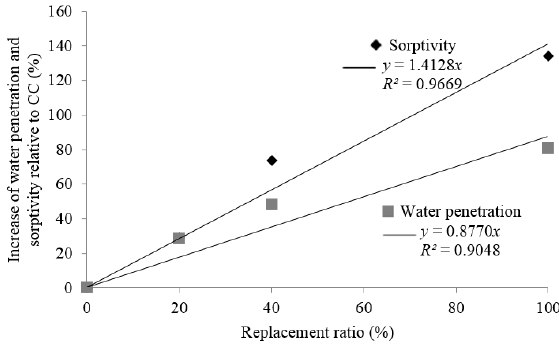
Figure 11. Loss of mean of water penetration and sorptivity increase relative to CC in relation to the replacement ratio.